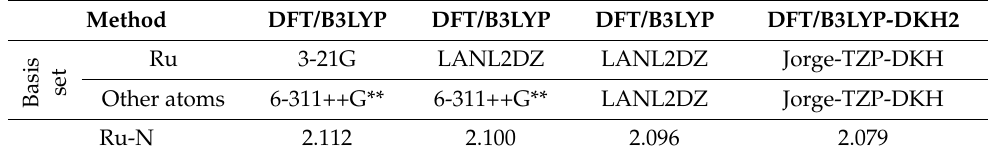
Table 2. The distances (in Å) between the Ru ion and neighboring N atoms for a RBY(PF 6 ) 2 molecular system calculated by different DFT methods. Method DFT/B3LYP DFT/B3LYP DFT/B3LYP